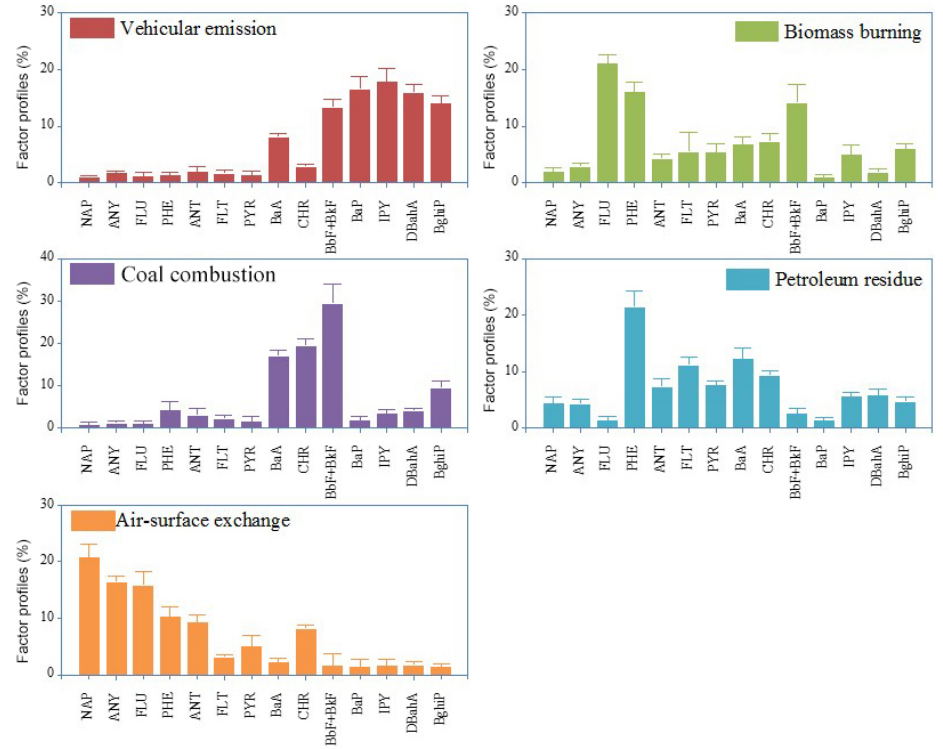
Figure 8. Profiles of the five factors resolved by the PMF model from all PAH data sets.